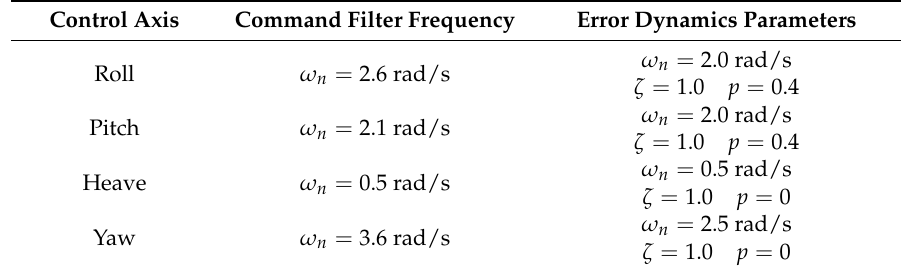
Table 1. Summary of command filter and feedback gain parameters for nominal controller